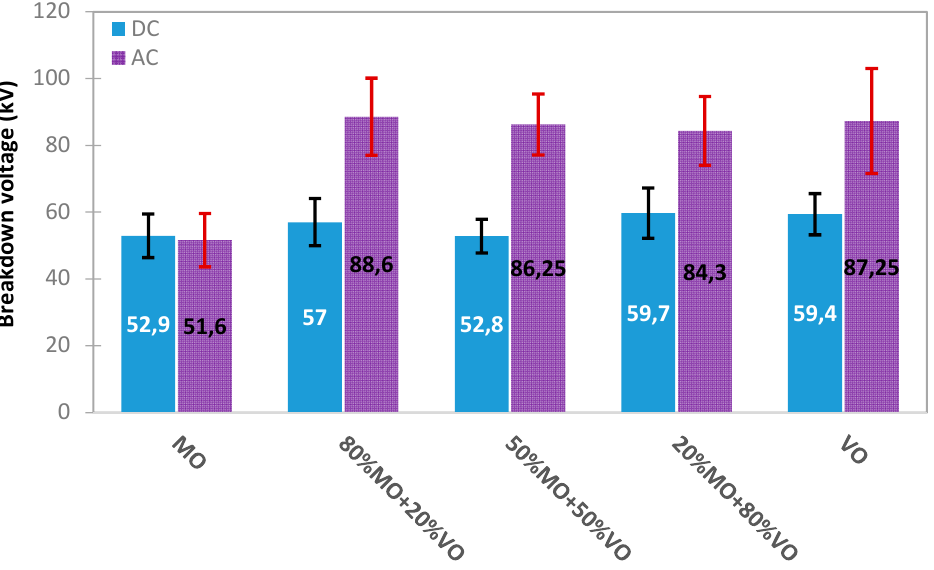
Figure 14. Average breakdown voltage of mineral oil and natural ester oil mixtures; the bars indicate the standard deviation.